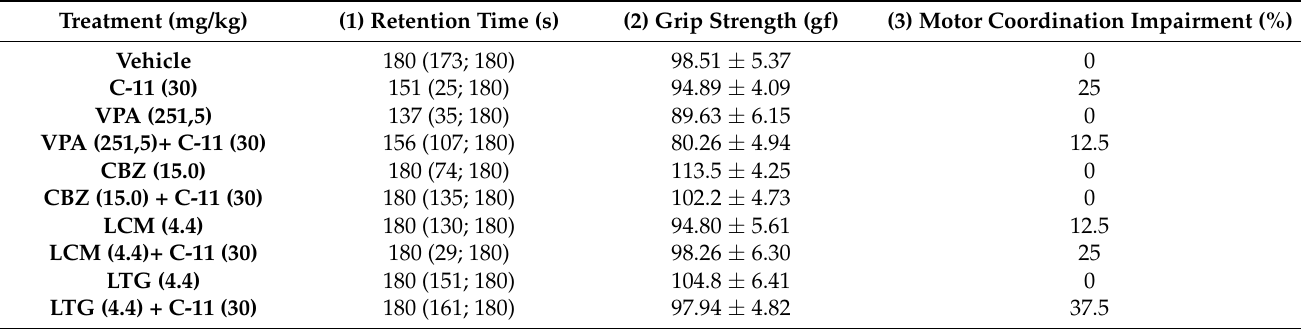
Table 2. Effects of C-11 and its combinations with classical antiepileptic drugs on long-term memory, muscular strength, and motor performancein mice.